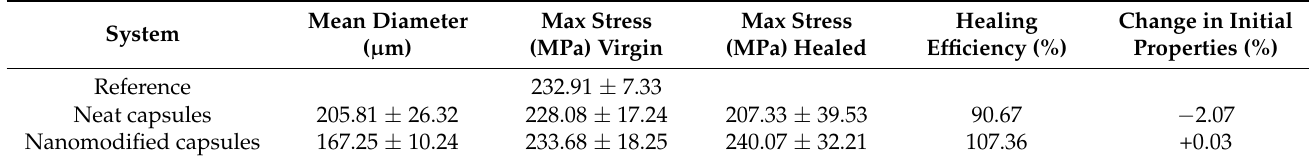
Table 3. Healing efficiency and change in initial mechanical properties of lap strap specimens con- taining neat and nanomodified capsules.